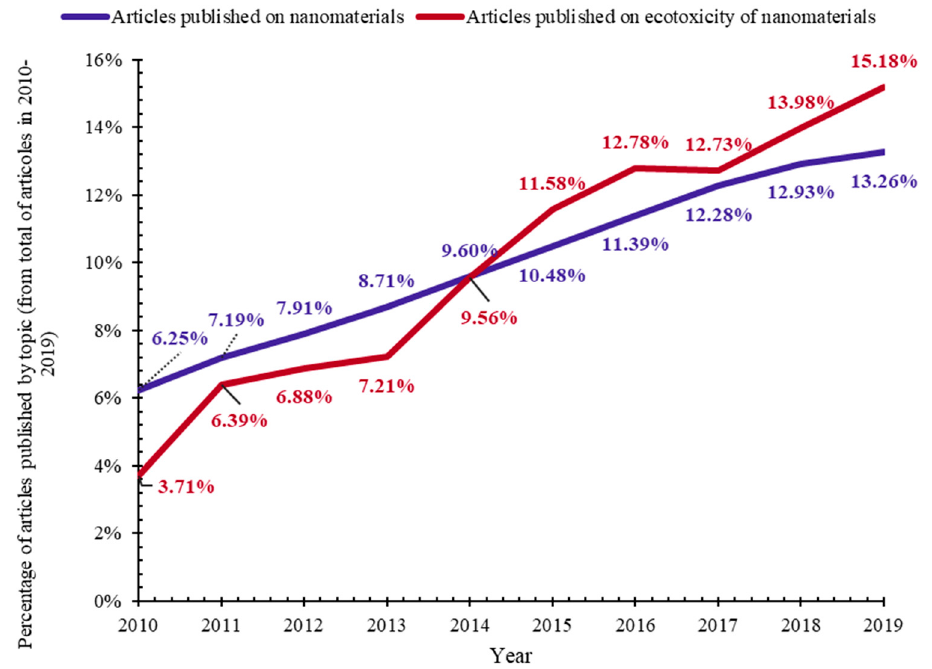
Figure 16. Bibliometric analysis of research on nanomaterials and their ecotoxicity from 2010 to 2019